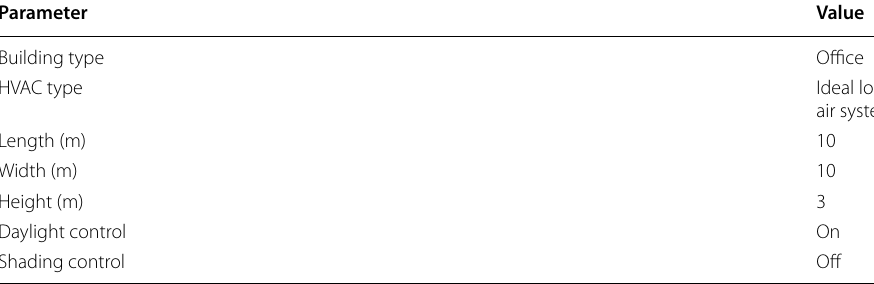
Table 6 Fixed parameter for the case study